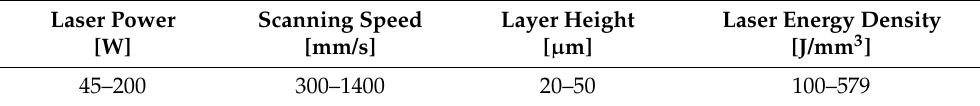
Table 1. The applied L-PBF processing parameters.